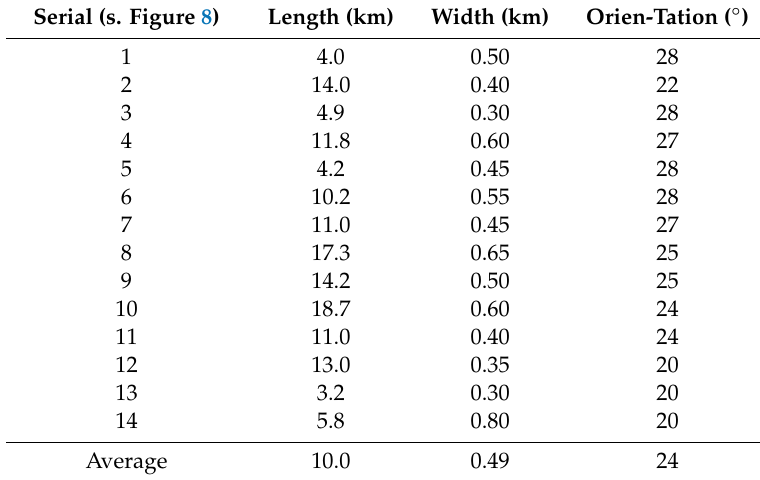
Table 8. Morphological Characteristics of linear dunes of El-Hebal Dune Field.